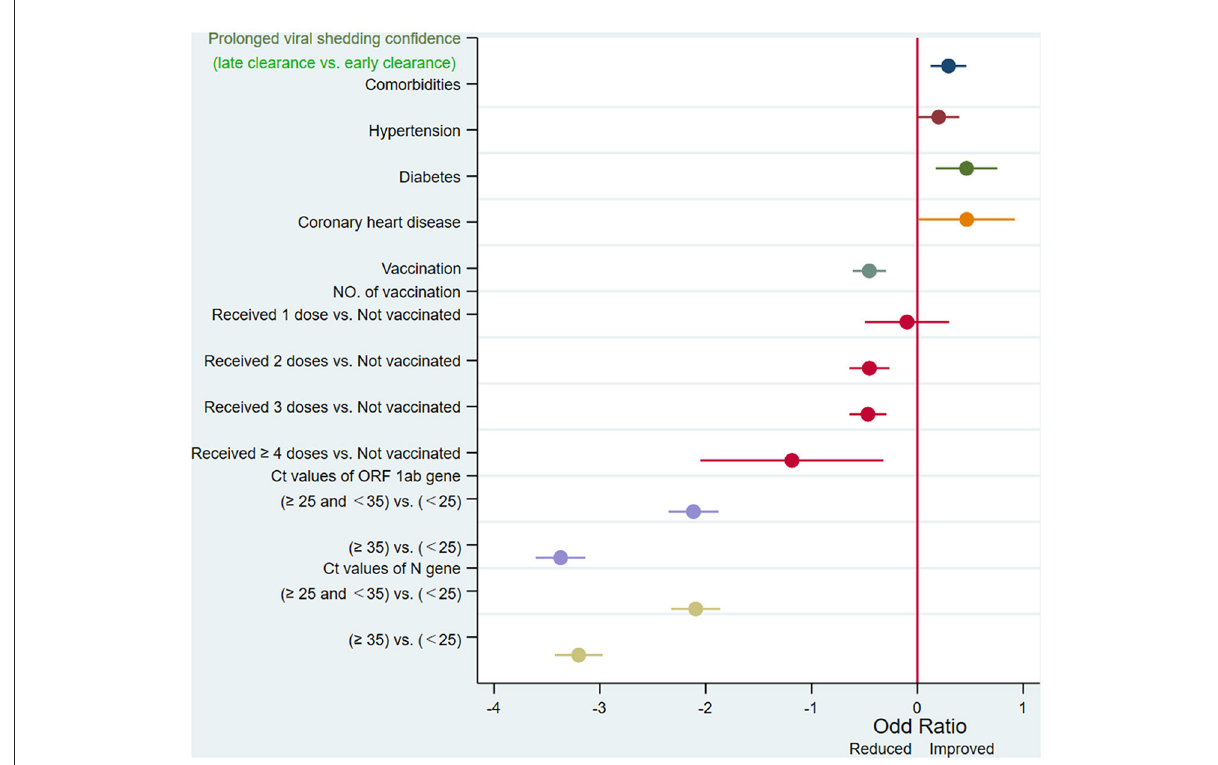
FIGURE2 Factors associated with persistently PCR-positive patients at univariate regression analysis. Ct, cycle threshold; ORF 1ab gene, open reading frame 1ab; N gene, nucleocapsid protein gene.